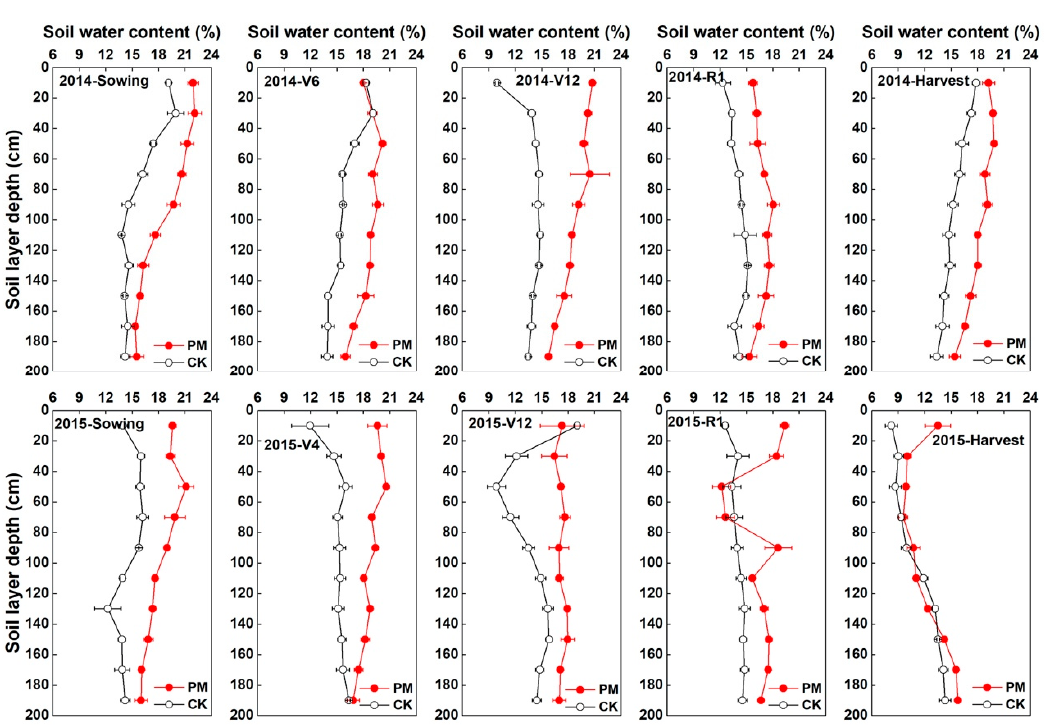
Figure 2. Soil moisture content in the 0–200 cm layer in mulched (PM) and check (CK) plots in 2014 and 2015. Sowing: sowing time, V4: four-leaf stage, V6: six-leaf stage, V12: twelve-leaf stage, R1: silking stage, and Harvest: harvest time. Error bars represent standard errors of the mean.